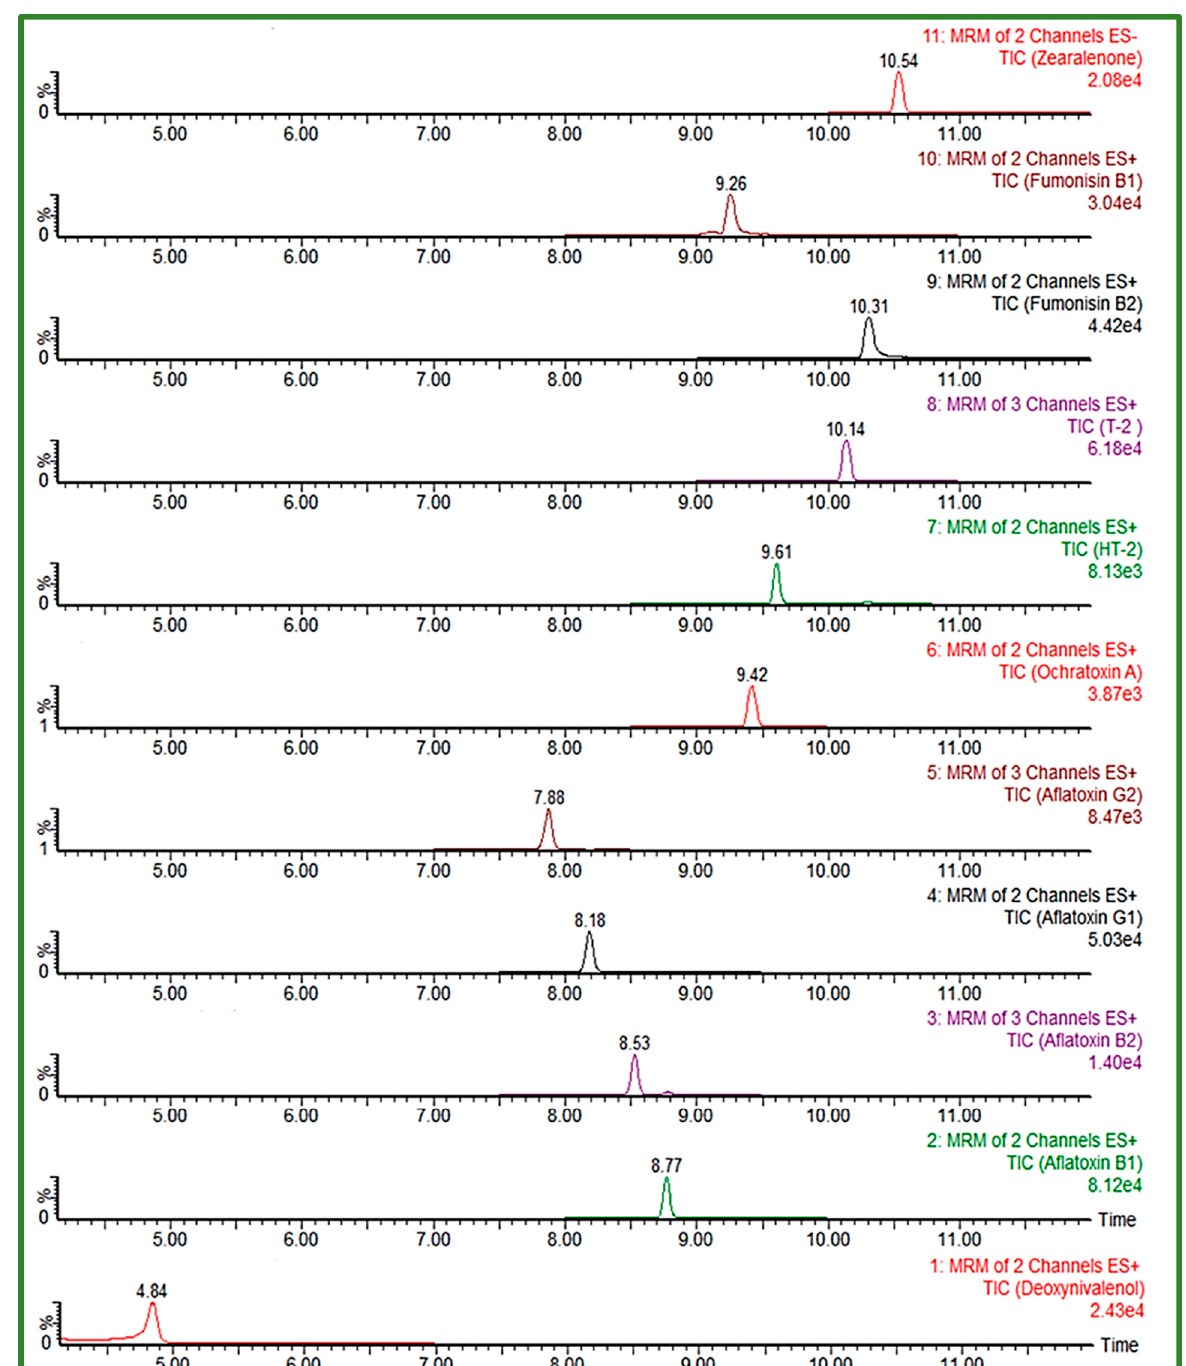
Figure 2. UHPLC-MS/MS chromatogram of 11 EU-regulated mycotoxins in spiked solvent (AFB1/AFG1 0.5 ng/mL, AFB2/AFG2 0.125 ng/mL, DON 50 ng/mL, FB1/FB2 37.5 ng/mL, ZEA 7.5 ng/mL, T-2/HT-2 2.5 ng/mL and OTA 0.25 ng/mL) obtained using Acquity HSS T3 column under optimized